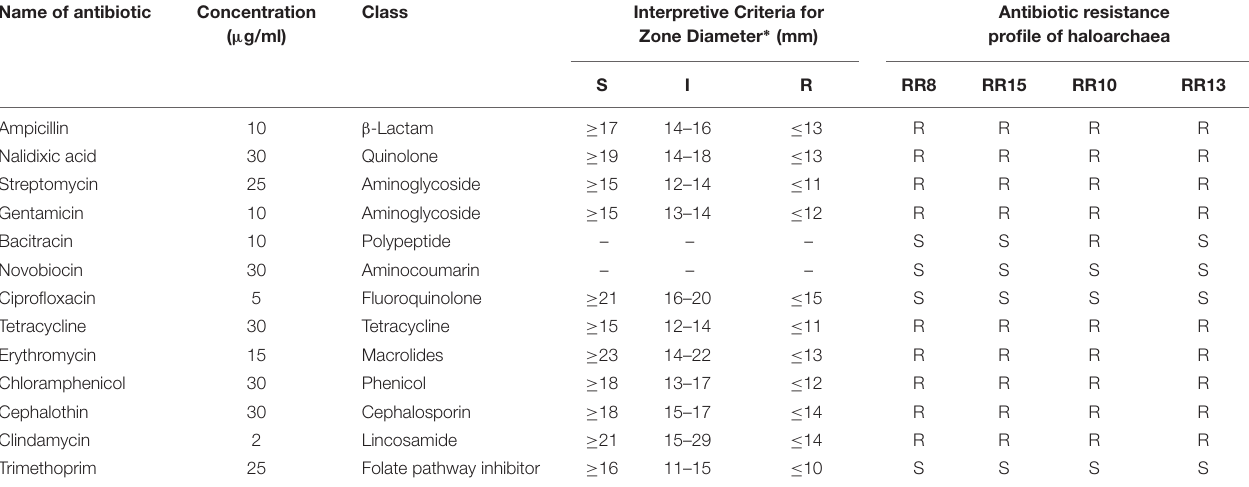
TABLE 1 | Antibiotic resistance profile of haloarchaea by disk diffusion method (Isolates: Haloferax prahovense RR8, Haloferax lucentense RR15, Haloarcula argentinensis RR10, and Haloarcula tradensis RR13). Name of antibiotic